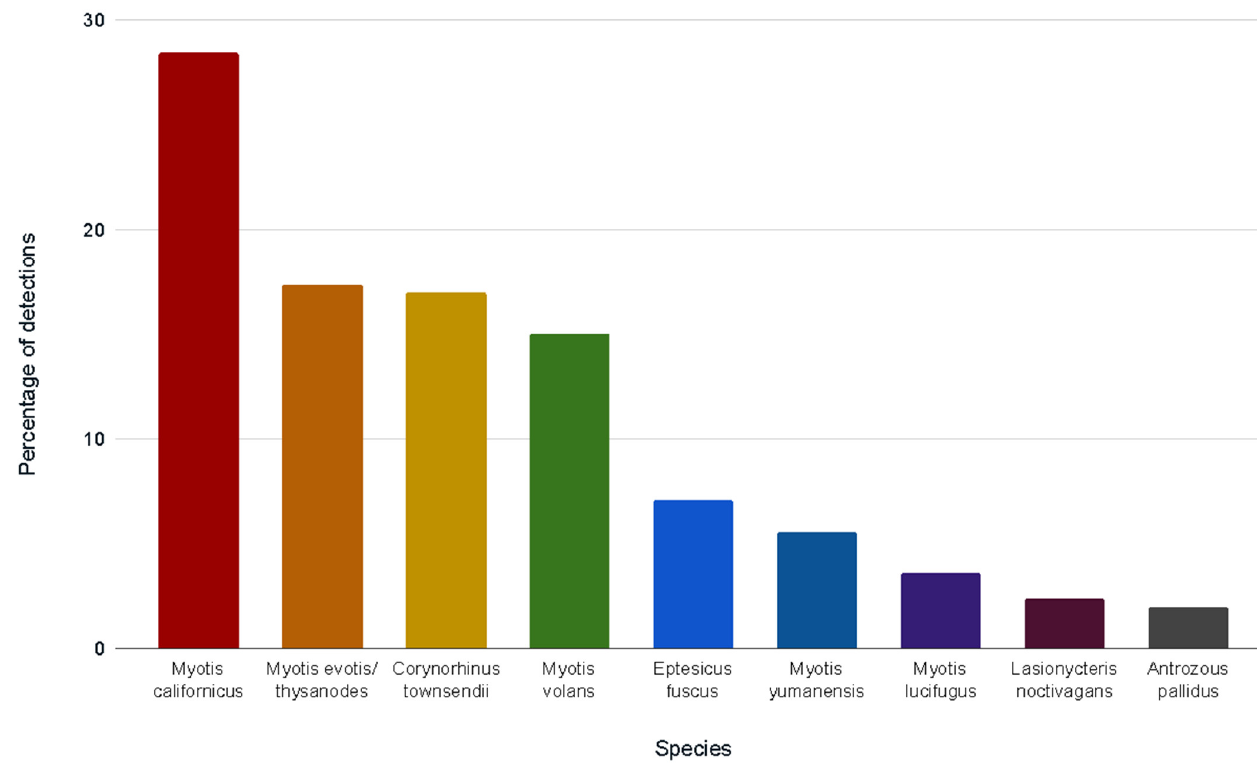
Figure 4. Bat species identifications, by percentage of total species detections (n = 253; multiple species per tree), from DNA analyses of guano collected from 83 tree hollows during 2017–2018 in Del Norte, Humboldt, and Mendocino counties, California (1 year; 8 sites). Lasiurus cinereus (absent Table 2. Bat prevalence (species frequency) by percentage per site, based on species identifications from DNA analysis of pooled guano collections from 83 hollows over the study period (April 2017– September 2018), at eight sites on the North Coast of California. Asterisks indicate: * Species of Con- servation Concern in the state of California; ** Species listed as Endangered by the IUCN.